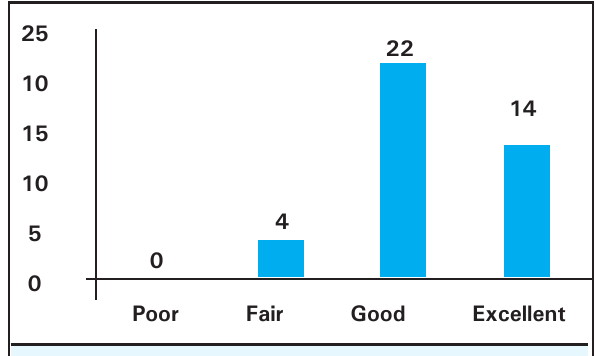
Figure 3. Showing the results of Harris Hip